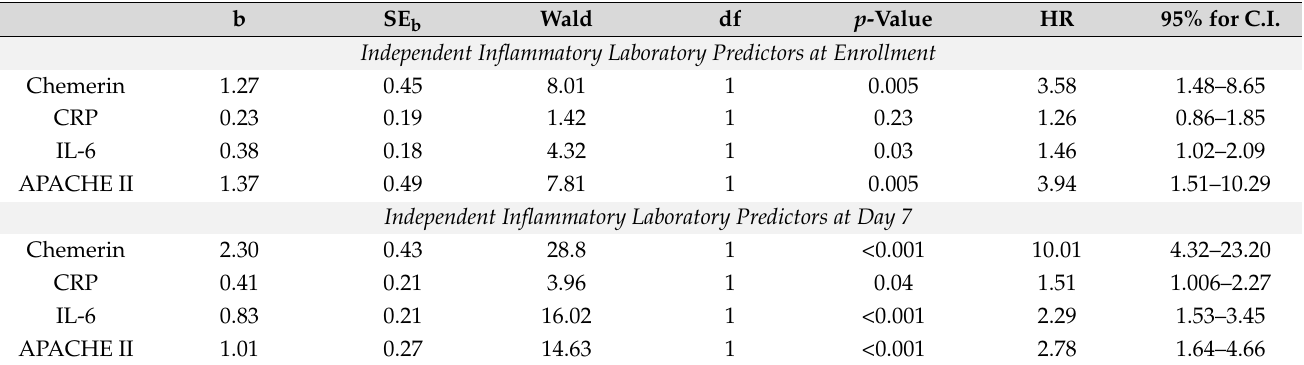
Table 4. Multivariate Cox regression analyses results for the independent laboratory predictors of mortality (expressed as quartiles) adjusting for APACHE II score in 102 septic